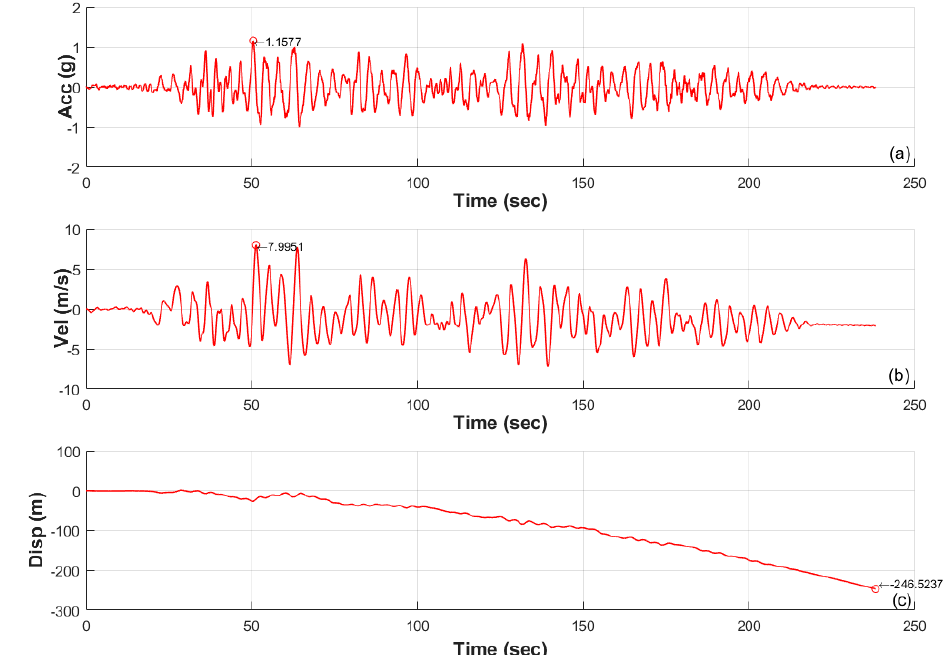
Figure 1. Results of the numerical integration of velocity and displacement without baseline correction from the acceleration measured in the shaking table test; ( a ) Acceleration; ( b ) Velocity; ( c )